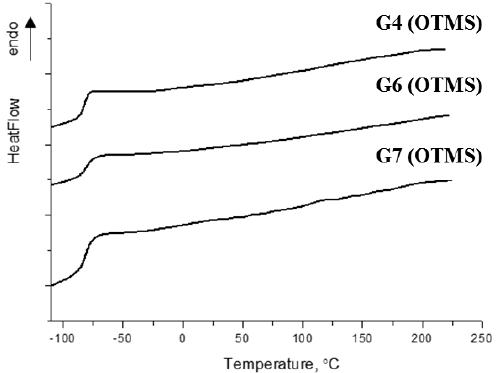
Figure 3. Thermograms for the 4th, 6th, and 7th generations of hybrid carbosilane-siloxane den-